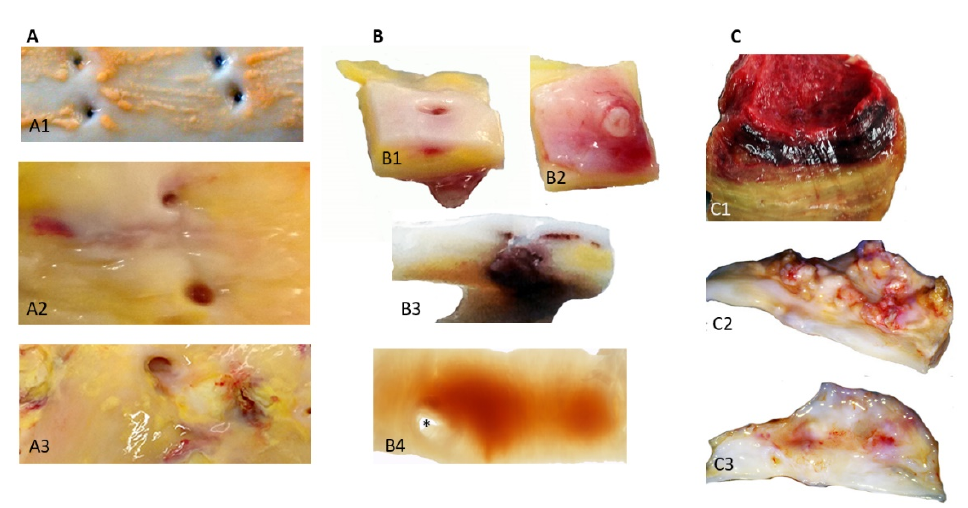
Figure 1. Macroscopic view of hemorrhages in human arterial lesions: ( A ) involvement of RBCs in the initial stages of human atherosclerotic lesions (( A1 ) aortic fatty streaks in human aorta and their relationship to intercostal ostia; ( A2 ) fibro-atheroma with limited subintimal bleeding; ( A3 ) more advanced lesions with numerous small hemorrhages and intimal breaches); ( B ) 0stial hematoma (( B1 ) ostial luminal view; ( B2 ) outside collateral view; ( B3 ) longitudinal trans-ostial section showing the local di ff usion of the hematoma; and ( B4 ) whole-mount immunostaining of Glycophorin A in peri-ostial clarified aortic tissue showing the hematoma di ff usion from the ostia (*)); and ( C ) ILT in AAA and aortic valve; ( C1 ) the multilayered intraluminal thrombus (ILT) of human AAA, where the most luminal layer (red) is extremely rich in RBCs and the subjacent layers are yellow / brown, demonstrating the release of heme and ferrous iron, and the metabolism of hemoglobin into bilirubin; ( C2 ) aortic view of a calcified aortic valve, with peri-calcification hemorrhages (red), where the macro-crystallized calcifications protrude from the fibrosa; and ( C3 ) view of the ventricularis of the same valve where the ventricularis surface is smoother than that of the fibrosa and the neo-angiogenesis network is visible (red)).